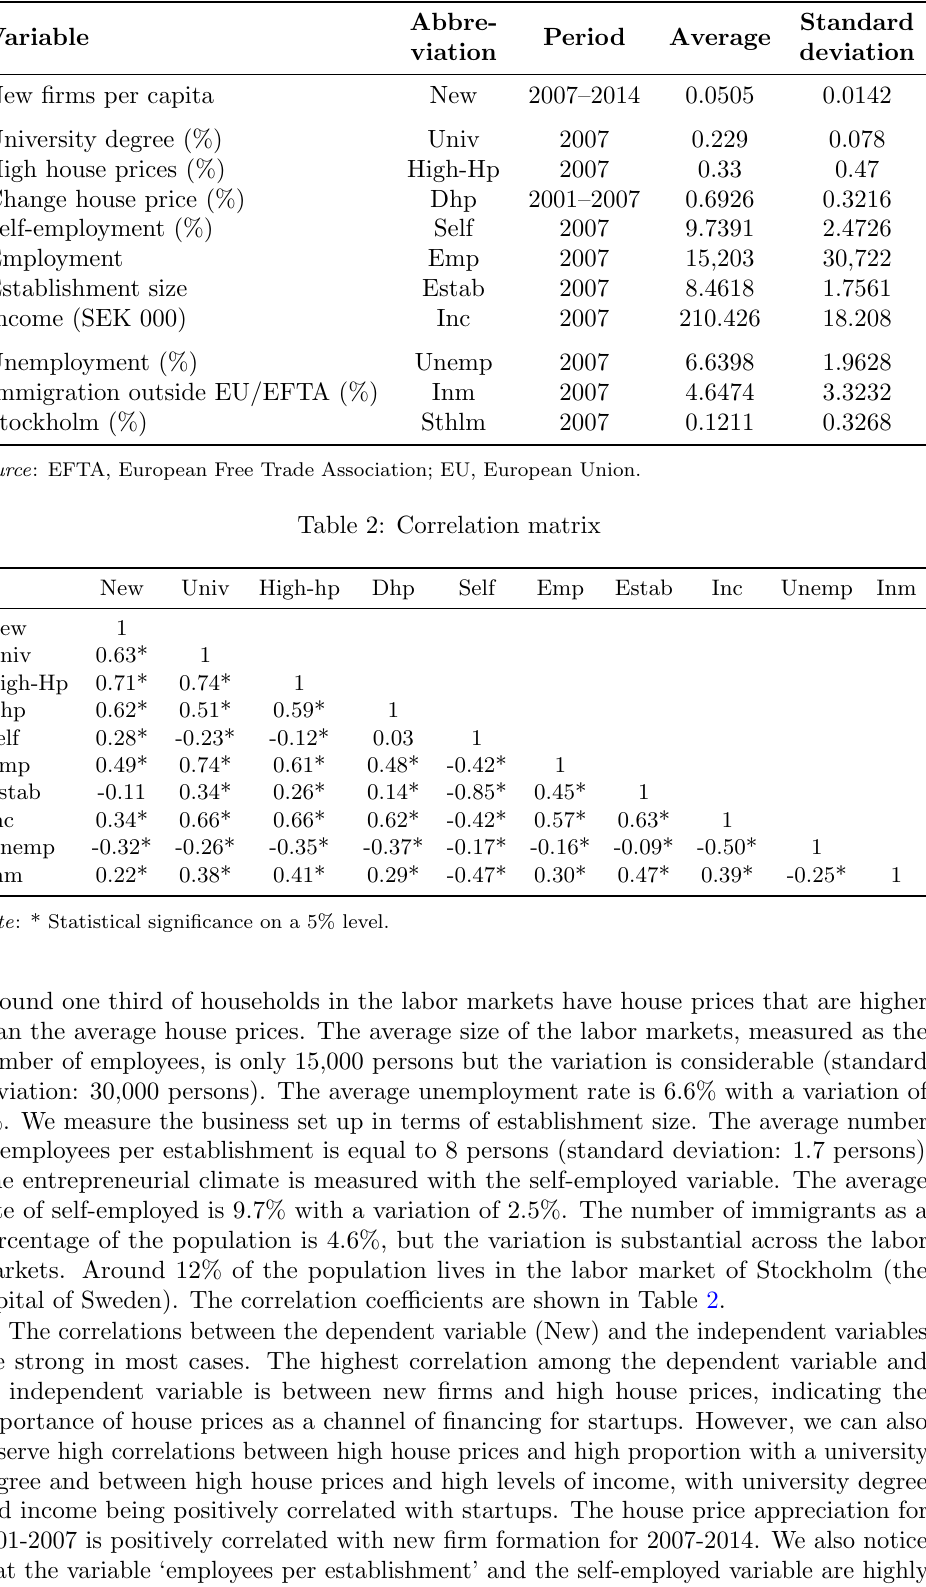
Table 1: Descriptive statistics of the data